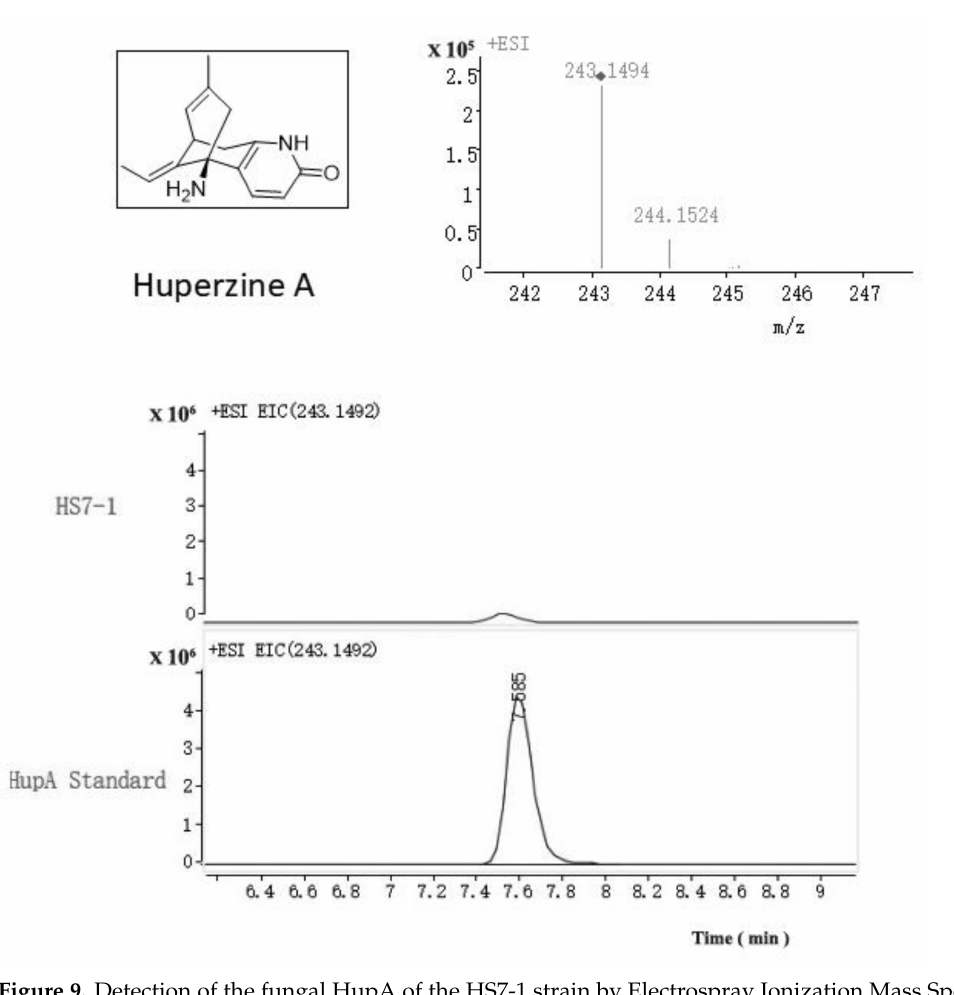
Figure 9. Detection of the fungal HupA of the HS7-1 strain by Electrospray Ionization Mass Spec- trometry (ESI-MS)